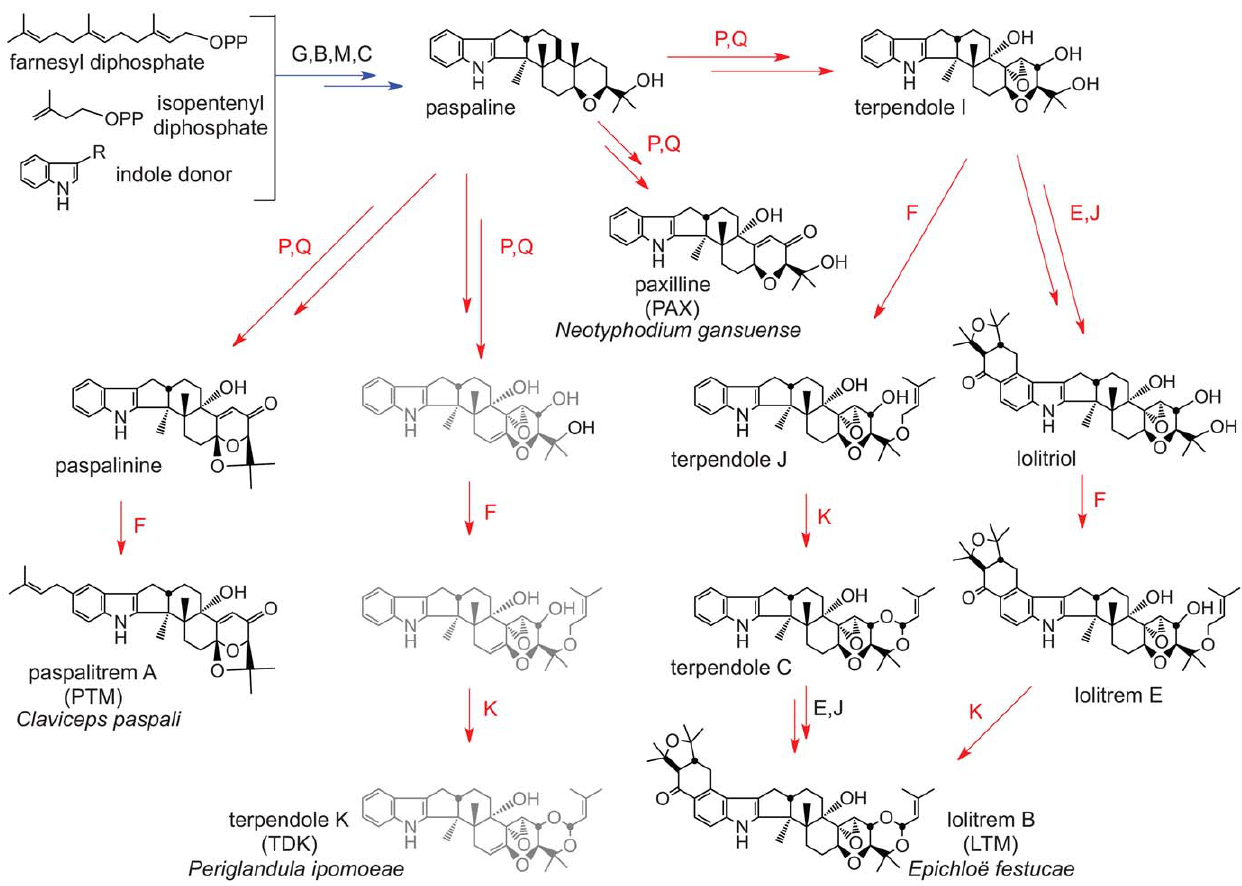
Figure 3. Summary of indole-diterpene biosynthesis pathway. Arrows indicate one or more steps catalyzed by products of the genes indicated, where each idt/ltm gene is designated by its final letter ( G=idtG/ltmG , etc.). Arrows and genes in blue indicate steps in synthesis of the first fully cyclized intermediate (paspaline). Arrows and genes in red indicate steps in decoration of paspaline to give the variety of indole-diterpenes in the Clavicipitaceae. Structures shown in gray are not yet verified.